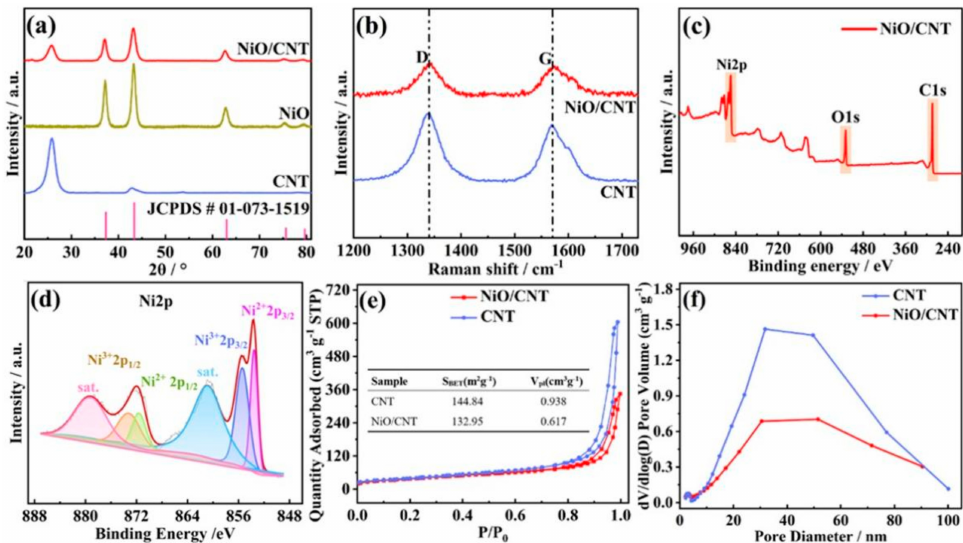
Figure 3. ( a ) XRD patterns of NiO/CNT, NiO and CNT catalysts; ( b ) Raman spectra of NiO/CNT and CNT catalysts; ( c ) XPS survey spectrum; ( d ) Ni 2p high-resolution spectrum of NiO/CNT; ( e ) N 2 adsorption–desorption isotherms; and ( f ) pore diameter distributions of NiO/CNT and